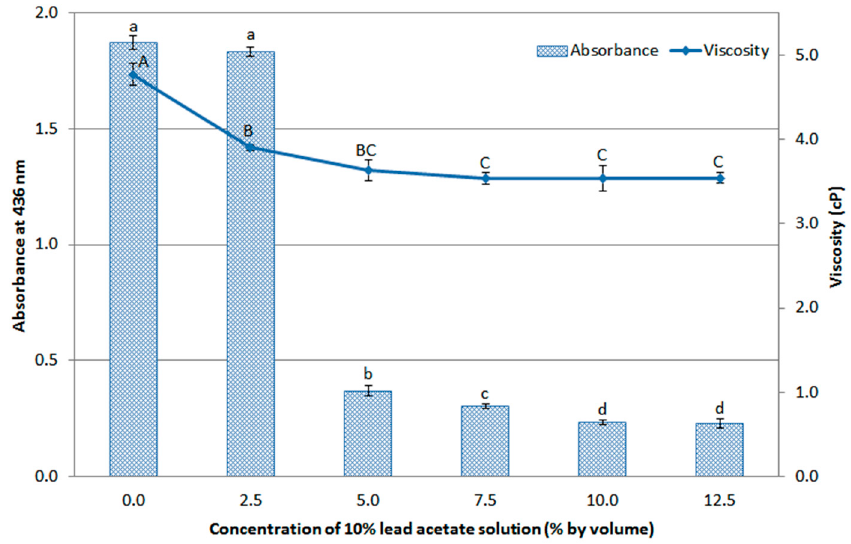
Figure 7. Effect of concentration of 10% lead acetate solution on viscosity and absorbance of the extracts from cacao pod husk. Different letters (a, b, c, d, A, B, BC, C) indicated significant differences between treatments ( p < 0.05).